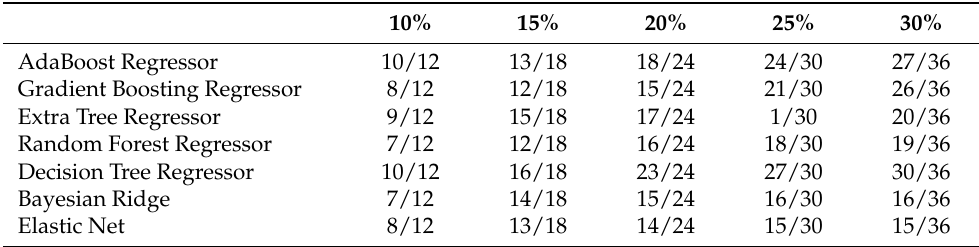
Figure 5. Evaluation Measures for each algorithm for SWDF. Table 7. TP values for test results of SWDF (Predicted Nodes/Actual nodes), 10% summary corre- sponding to 12 nodes etc.